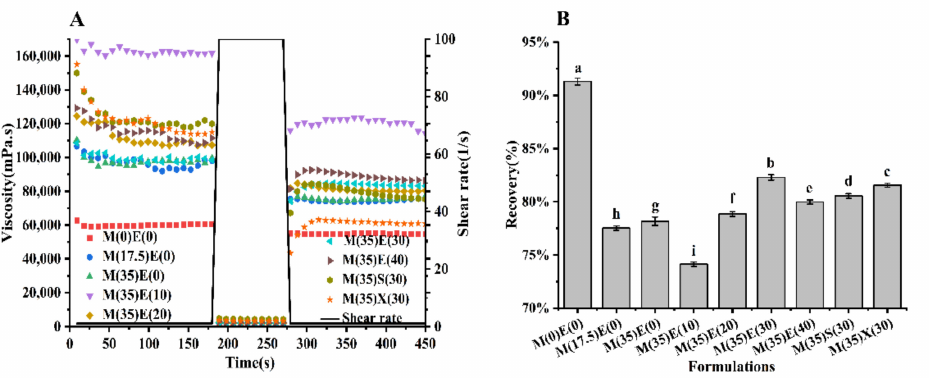
Figure 4. ( A ) Recovery tests of inks conducted at 75 ◦ C under alteration of high (100 1/s) and low (1 1/s) shear rate. ( B ) Shear recoverability of inks determined as the percentage of viscosity obtained during the first 30 s in the third step after high shear rate (100 1/s) based on the average viscosity obtained in the first step. Different lowercase letters denote significant differences ( p <